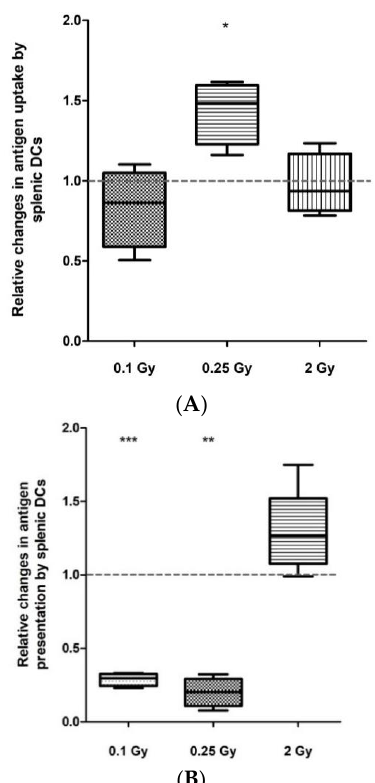
0.1 Gy nor 2 Gy had any effect, an almost 1.5-fold increase in OVA-peptide uptake was measured in DCs isolated from mice irradiated with 0.25 Gy (Figure 2A and Supplementary Figure S1).